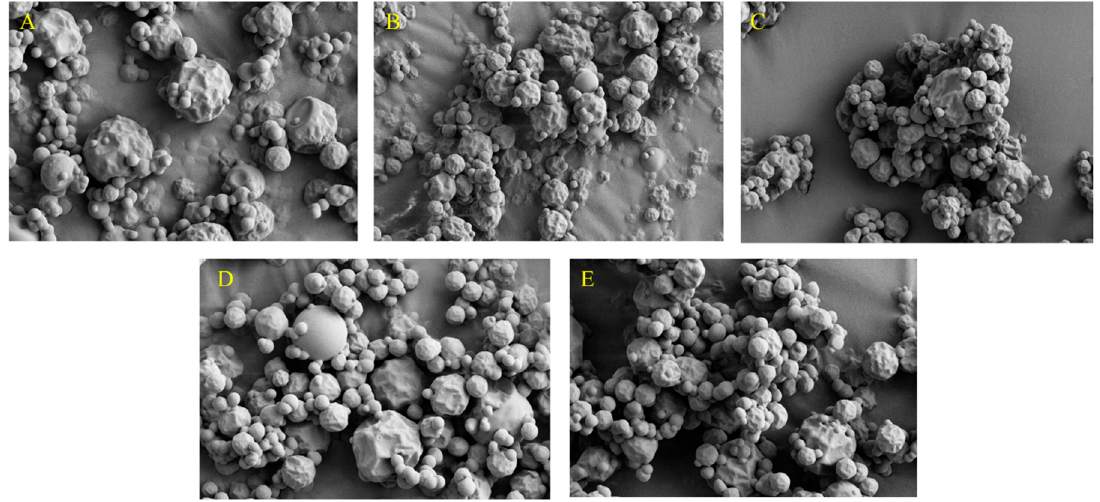
Figure 2. Scanning electron micrographs of spray dried microparticles: ( A ) 15% Maltodextrin, ( B ) 20% Maltodextrin, ( C ) 25% Maltodextrin, ( D ) 30% Maltodextrin, ( E ) 35% Maltodextrin.